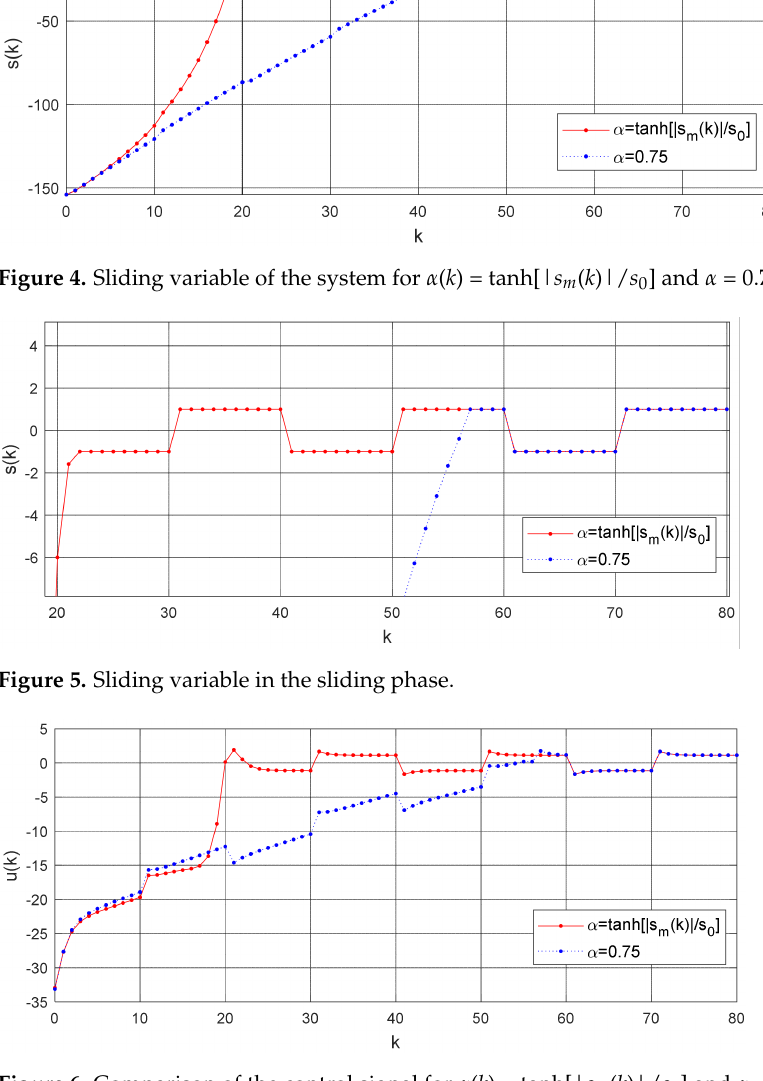
Figure 6. Comparison of the control signal for α ( k ) = tanh[| s m ( k )|/ s 0 ] and α =